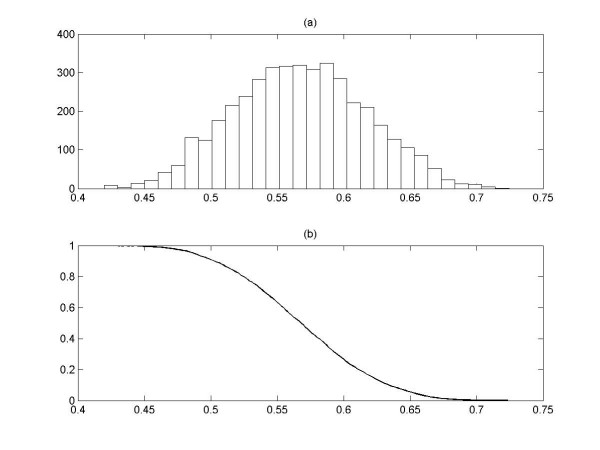
The relationship between ρkC and P-value. (a) Top panel shows the distribution of the strength value ρkC for random expression data. The x-axis corresponds to the strength value ρkC and the y-axis the number of values of ρkC that fall within the range of ρkC. (b) The bottom panel shows how the P-value can be calculated by integrating the random distribution. The x-axis corresponds to the strength value ρkC and the y-axis P-value.